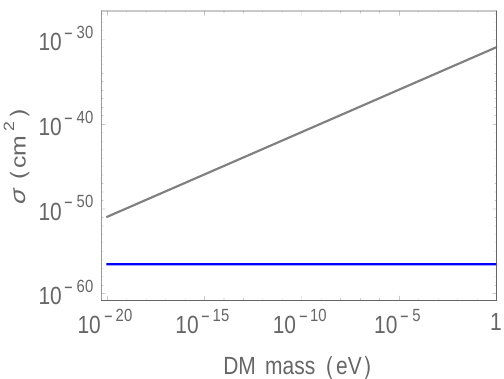
Figure 7. Cross-section vs. mass of DM in scalar-mediated neutrino-DM scattering. The blue and grey lines represent the cross-section with scalar mediator and the same required to induce 1% suppression of incoming (cid:13)ux respectively. Here, energy of incoming neutrino E (cid:23) = 1 PeV, mediator mass m (cid:1) = 200 GeV and f l g (cid:1) v (cid:1) = 0 : 1